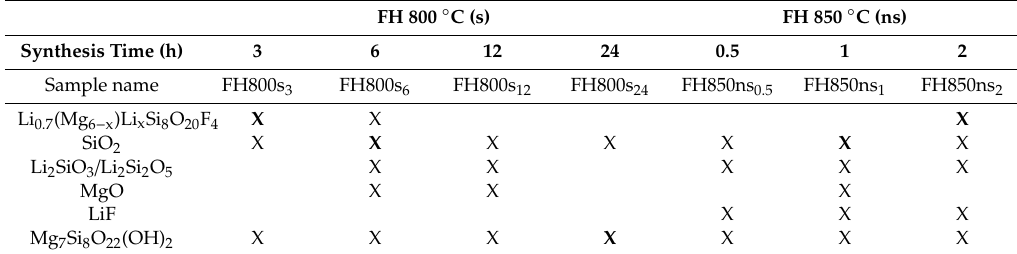
Table 1. Phase distribution of the samples characterized by XRD.